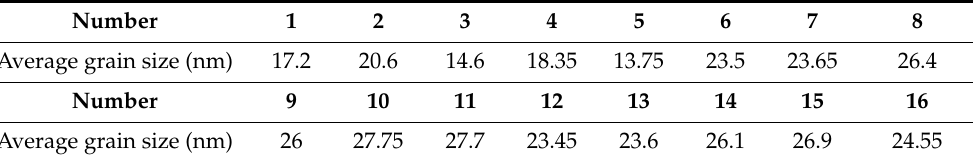
Figure 5. XRD pattern of Ni / ZrO 2 gradient coatings. Table 3. Average grain size of Ni / ZrO 2 gradient coatings.